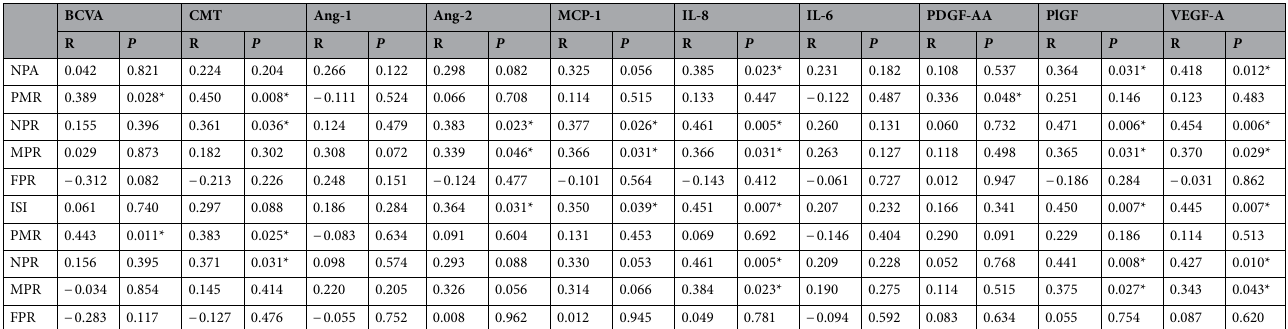
Table 3. Correlation of total ischemia in different retinal zones with visual acuity, central macular thickness, and levels of cytokines. BCVA: best-corrected visual acuity, CMT: central macular thickness, FPR: far- peripheral region; ISI: ischemic index, MPR: mid-peripheral region, NPA: non-perfusion area, NPR: near- peripheral region, PMR: peri-macular region, R: Spearman’s correlation coefficient. P -values were calculated using Spearman’s correlation. * P -value <